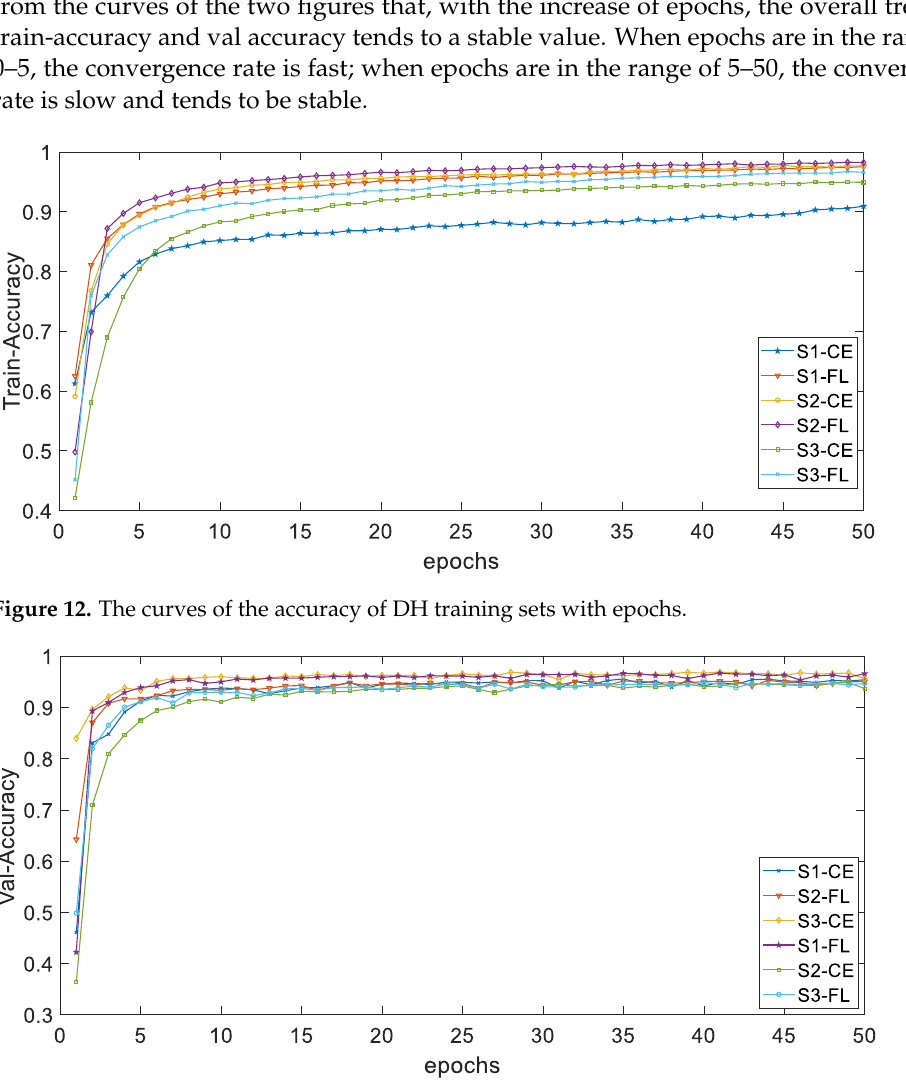
Figure 13. The curves of the accuracy of D H validation sets with epochs.